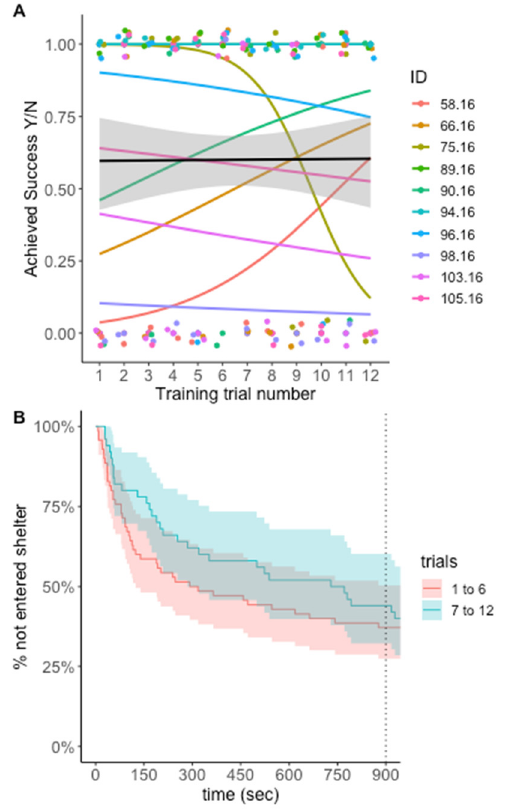
Figure 5. Measurements of training trial success for Experiment 2—Cross-modal same/different assay. ( A ) Likelihood of entering the C+ door in the 15 min time limit (successful training trial). Individuals did not improve in proportion of successful trials over time. ( B ) Survival curves for time to enter correct shelter with 95% confidence intervals. Curves represent early trials (1 to 6) and late trials (7 to 12). Dotted line indicates trial end time. Table 2. Model results for Experiment 2—Cross-modal same/different assay. All models were created with behavioral data from training trials. ∆ AIC is the difference between the AIC of the model with and without trial number as a predictor. Positive ∆ AIC indicates the model shown had a higher AIC value and is a worse model fit than the model without trial number. Including trial number in this model did not significantly improve model fit, indicating P. laevifrons did not improve likelihood of success over training trials.